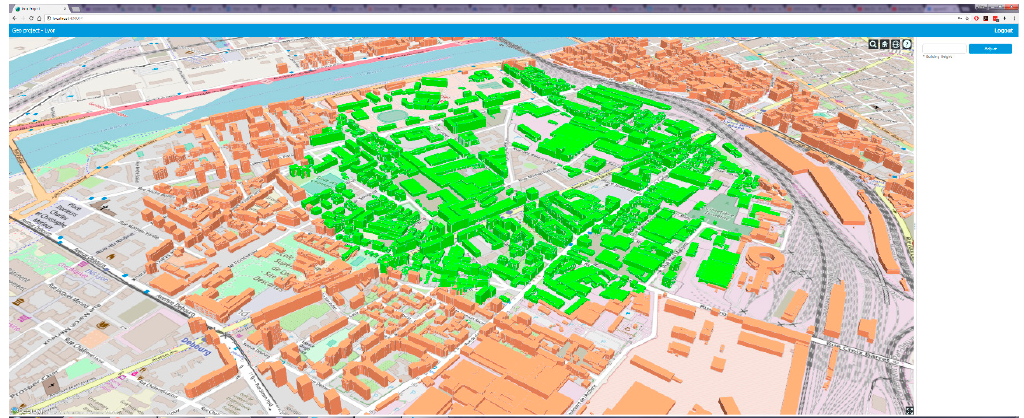
Figure 1. Visualization of a geoquery by the proposed system.